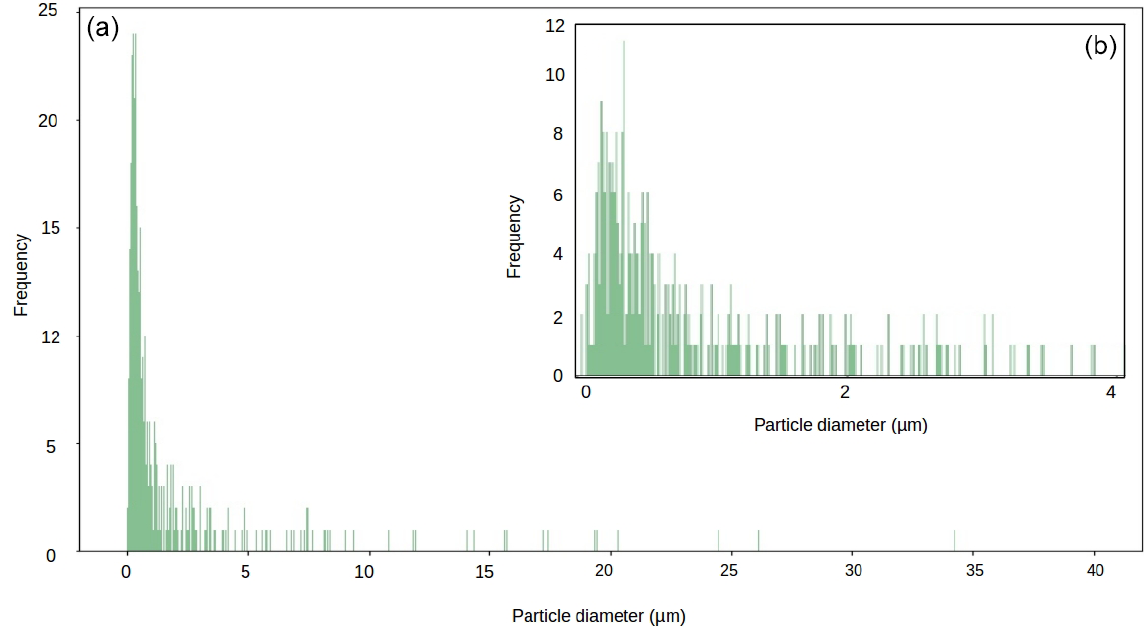
Figure 6. Particle size diameter for our local mineral dust sample (panel (b) shows magnification of 0–4µm